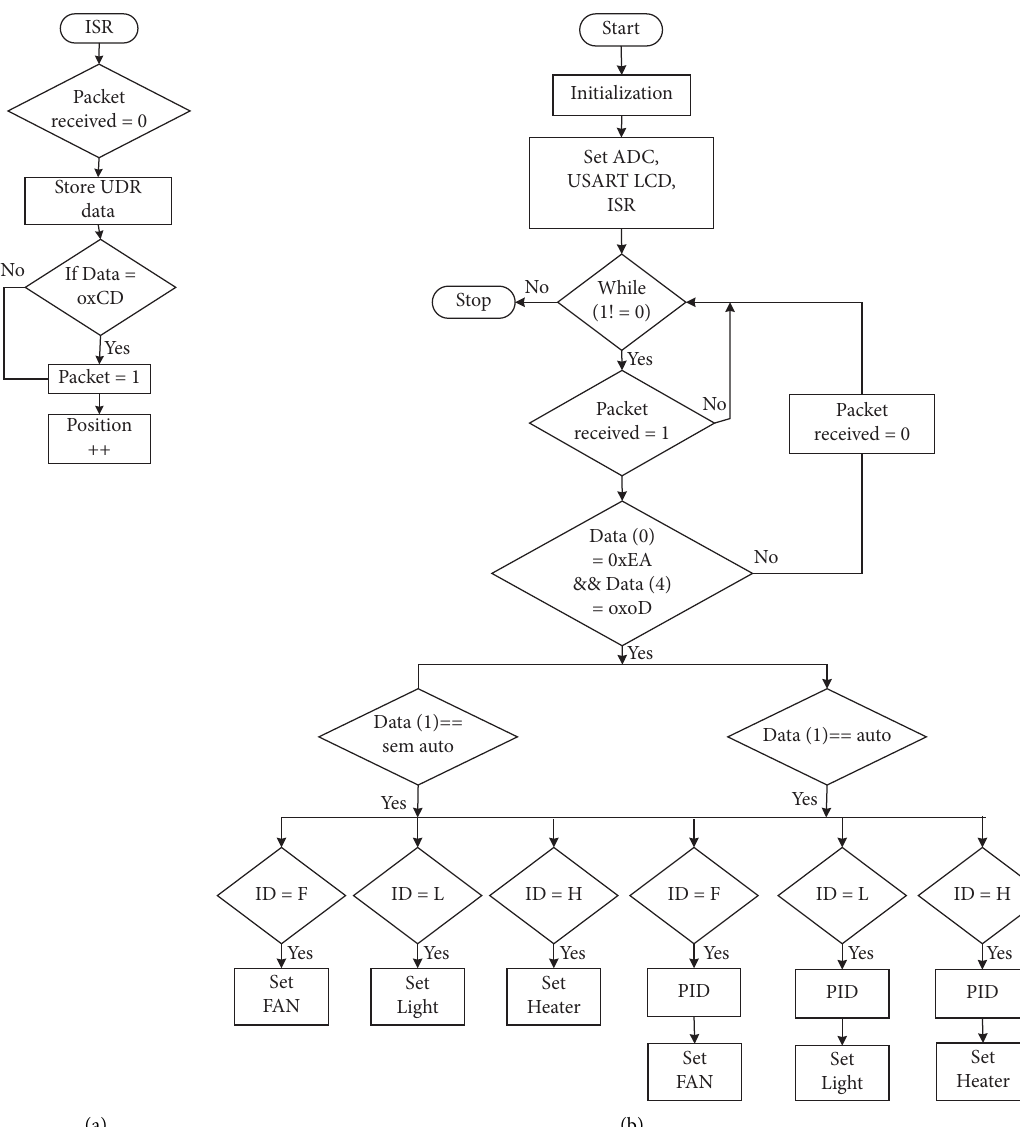
Figure 9: Flowchart for the receiver section (a). Flowchart for interrupt for the receiver section